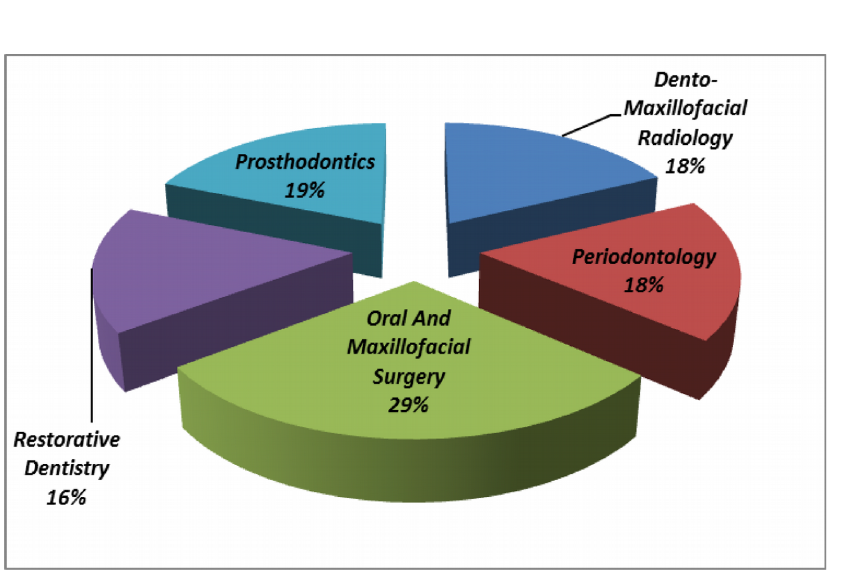
Figure 7. Clinics appointment rates in the dental hospital - for 4 months (Tekin & Erol,